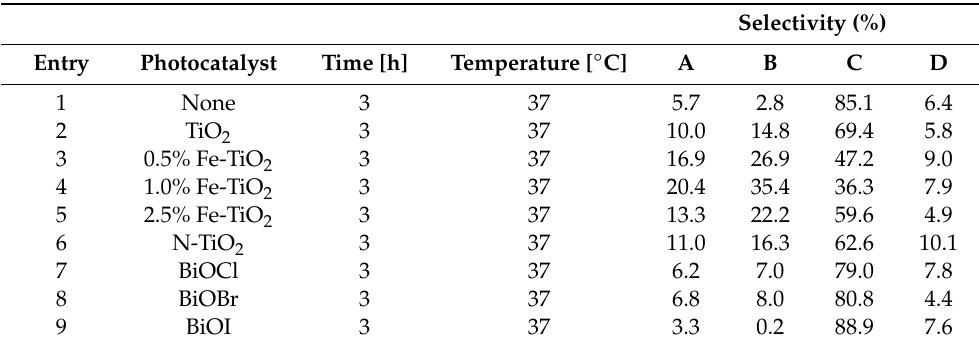
Figure 3. Scheme of the photocatalytic reactor.